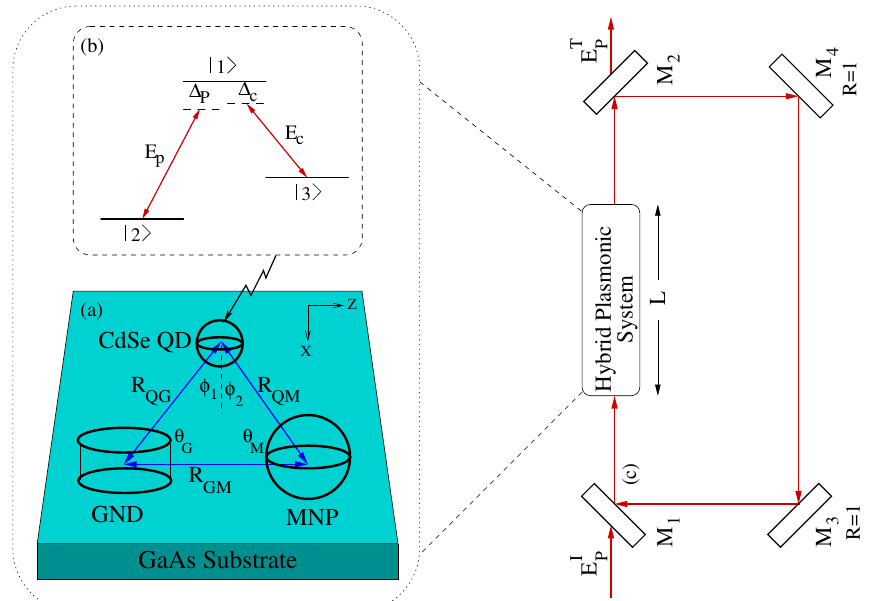
Figure 1. ( a ) The MNP–GND–QD hybrid system setup. ( b ) Λ -type atomic configuration of the QD. ( c ) Unidirectional ring optical cavity having four mirrors and the MNP–GND–QD hybrid system of length L . The mirrors M 3 and M 4 are perfect mirrors. The incident and transmitted fields are denoted by E I p and E T p